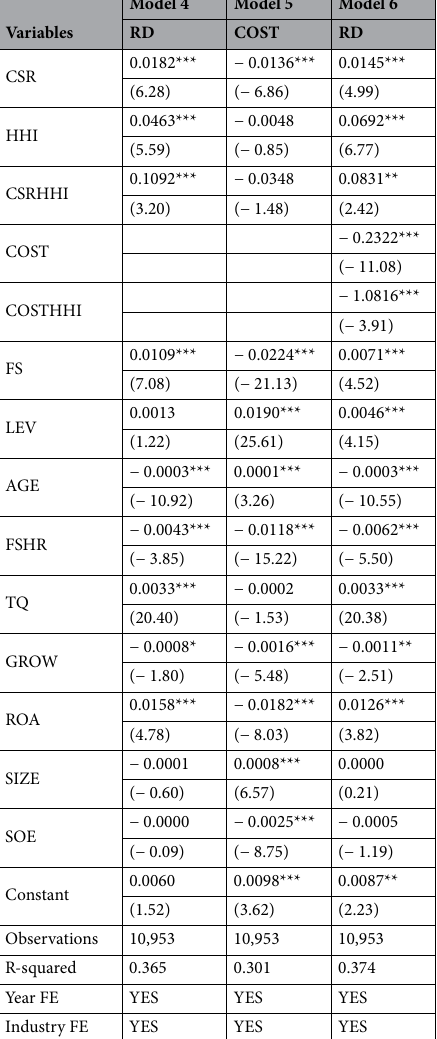
Table 5. The moderation effect of market competition degree. ***, ** and * respectively indicate that the parameter estimation is significant at the levels of 0.01, 0.05 and 0.1. The “t” value is in